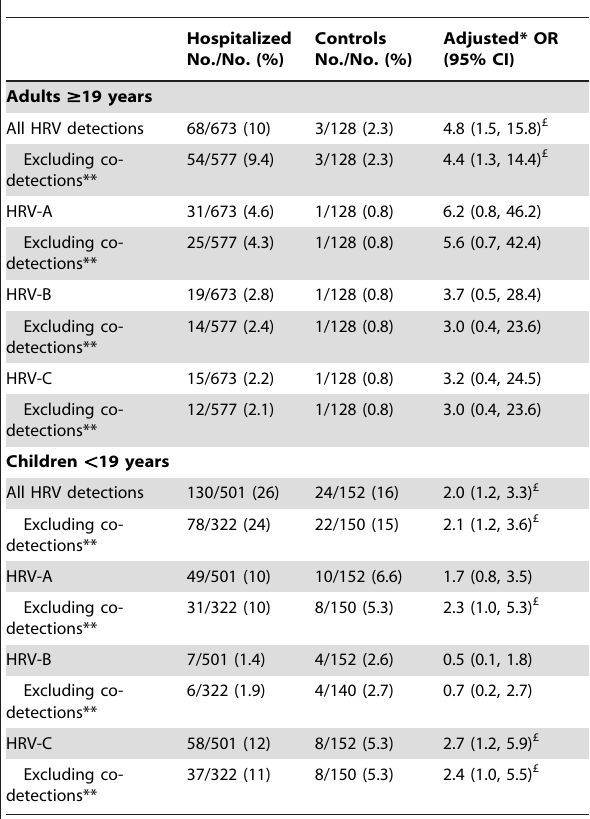
Table 5. Comparison of HRV detections among hospitalized enrolled patients and controls, Sa Kaeo Province, Thailand, September 1, 2004–August 31, 2005.